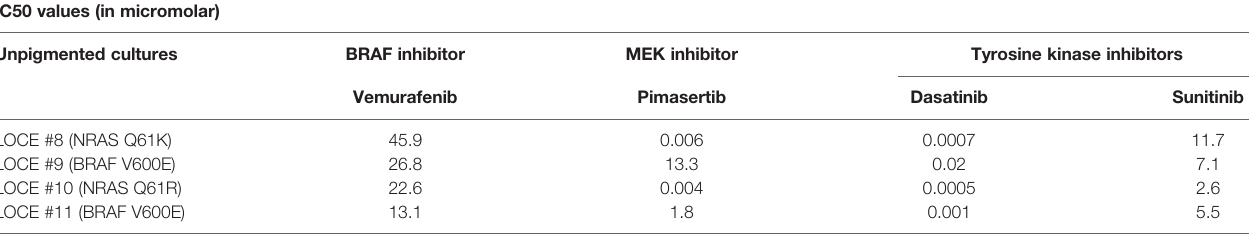
TABLE 3 | Unpigmented primary cultures display an intrinsic resistance to MAPK inhibitors and vulnerability to